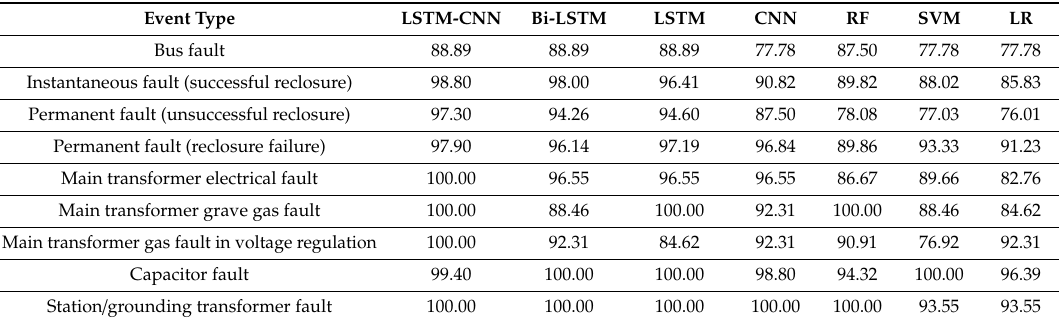
Table 10. Comparison of recall of this model with other models.